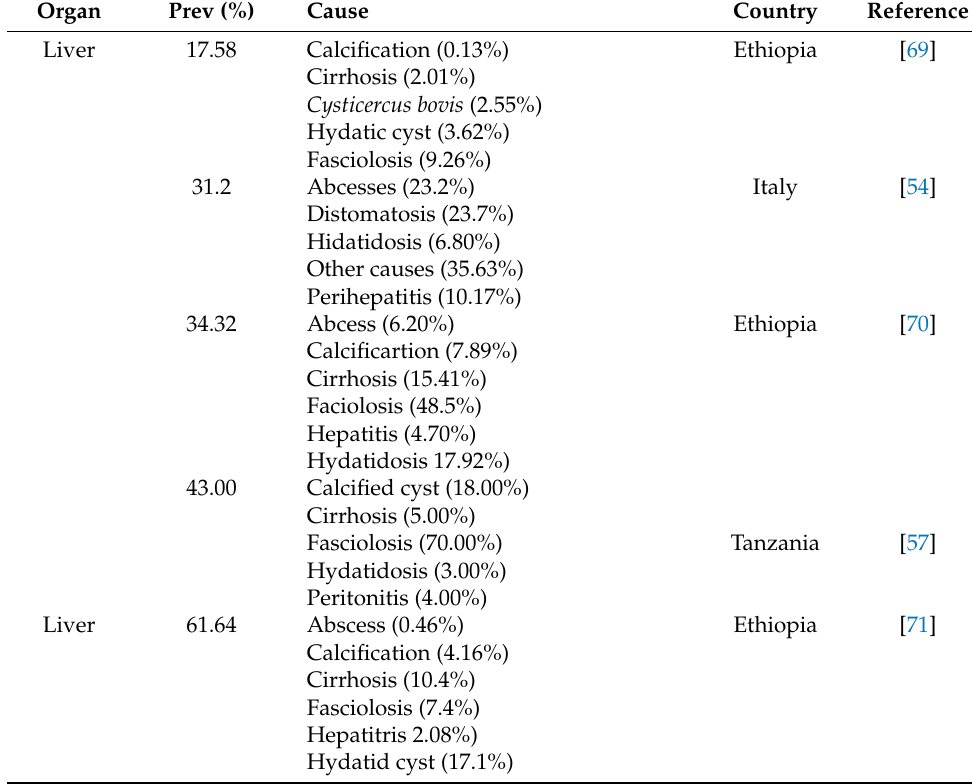
Table 3. Causes of condemnation of bovine